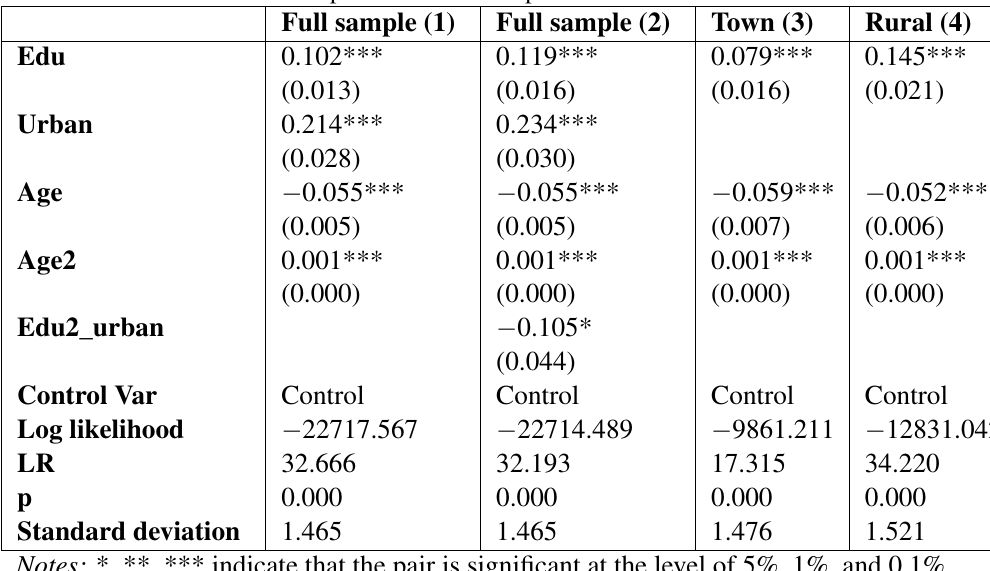
Table 2 Semiparametric ordered probit model estimation